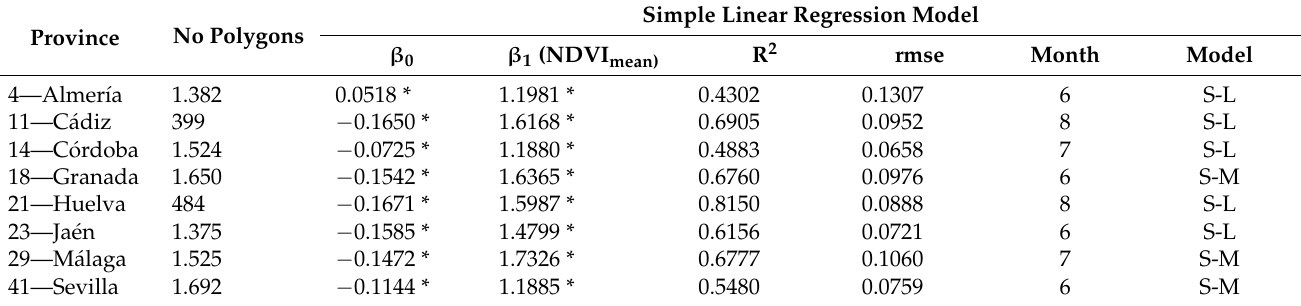
Table 6. R-squared, rmse, month, and best-fit simple regression model for each observation area